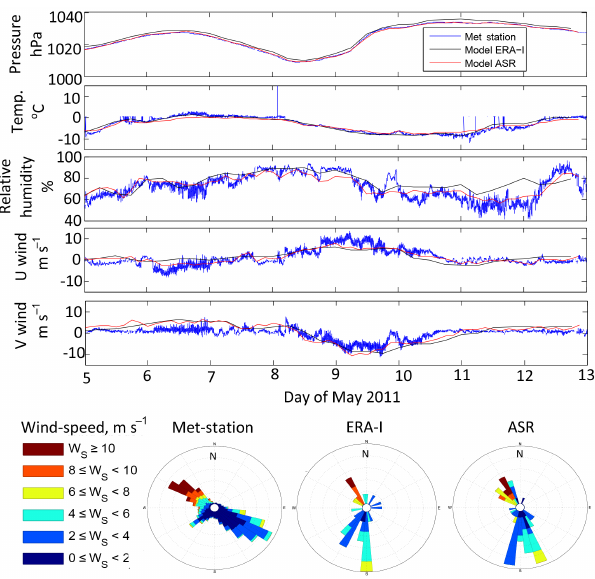
Figure 3. Sea-level pressure in ERA-I shown as a function of lat- itude and longitude at 12-hourly intervals for the duration of the field campaign, starting on JD 125 (5 May). Overlain in white are Ny-Ålesund and the CMET flight tracks as a function in time (full extents of flights 3 and 4 are shown at JD 128.5 and for flight 5 at JD 132).